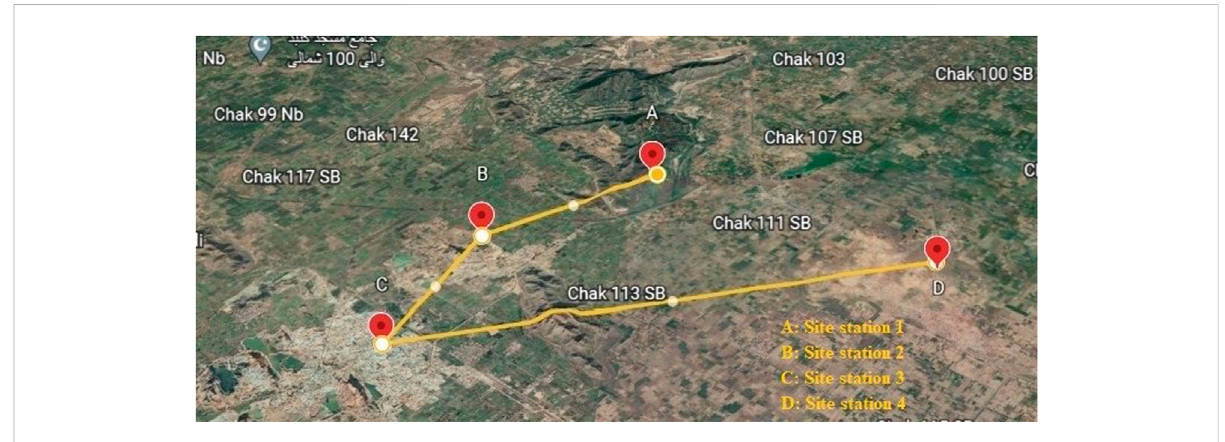
FIGURE 1 Test station in the Sargodha crushing